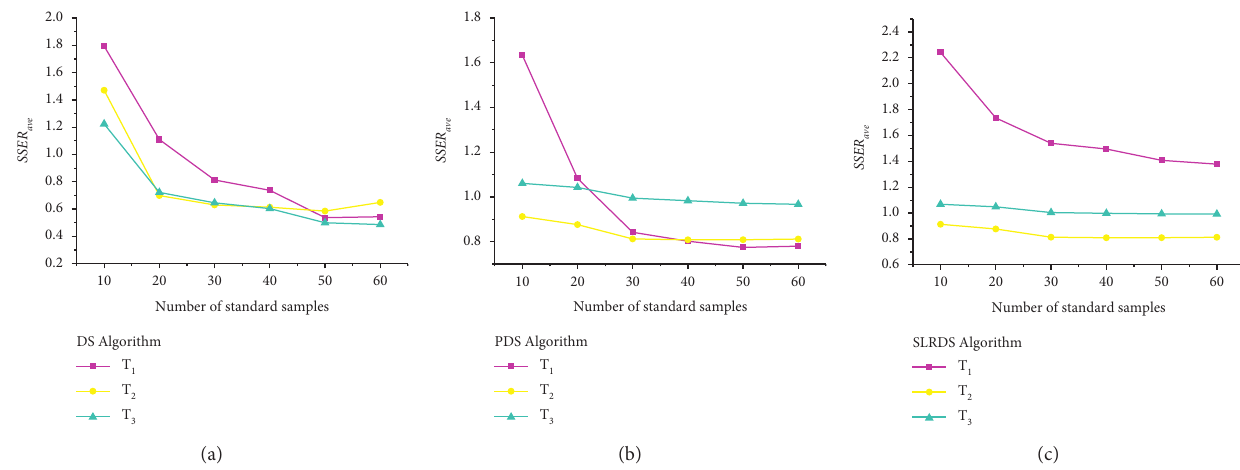
Figure 4: Variation of SSER ave of the three target spectrometers with the number of standard samples from three spectral Table 4: Differences between the target and master spectra before and after standardization. Spectrometer